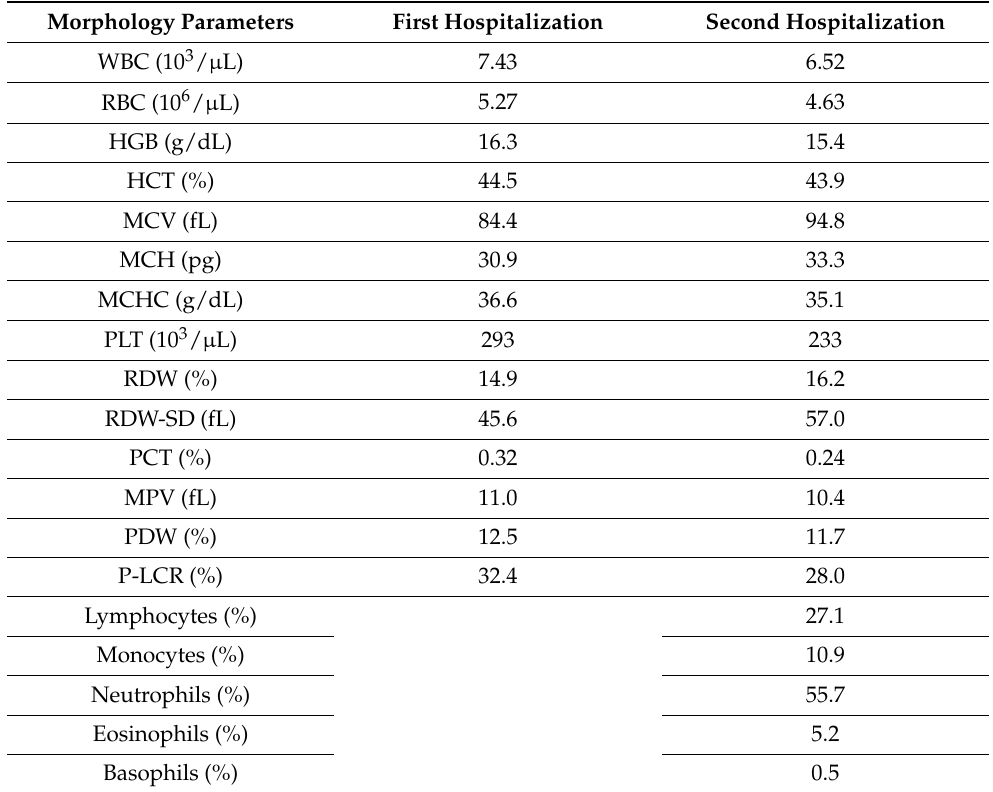
Table 3. The morphology results during both